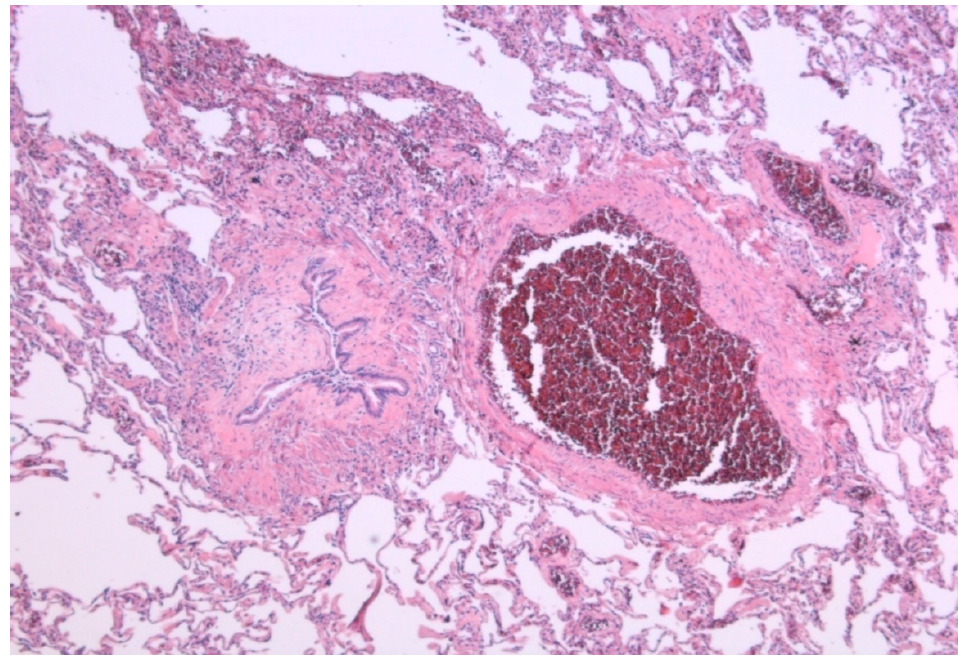
Figure 2. Histological image, magnification 100×, with obliteration of the endobronchial lumen, compared with the vascular lumen, in a patient with chronic rejection (courtesy of Dr. Clara Salas).